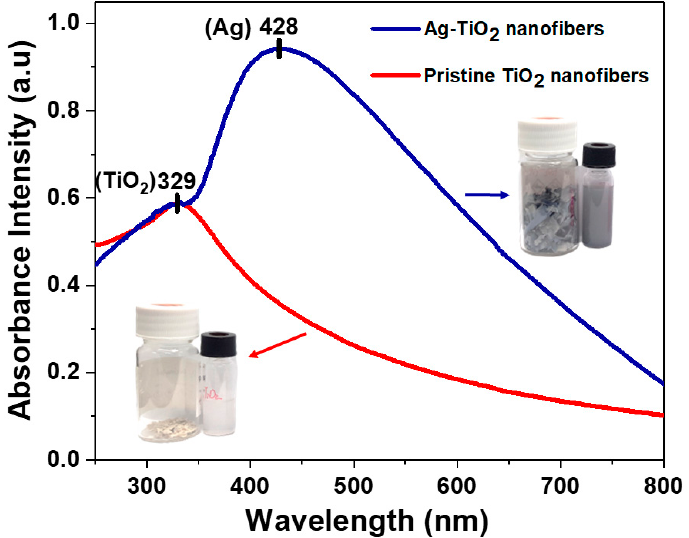
Figure 3. UV-Vis absorption spectra for both Ag-TiO 2 (blue) and pristine TiO 2 (red) nanofibers alongside photographs of the nanofibers themselves and when they are dispersed in solvent.